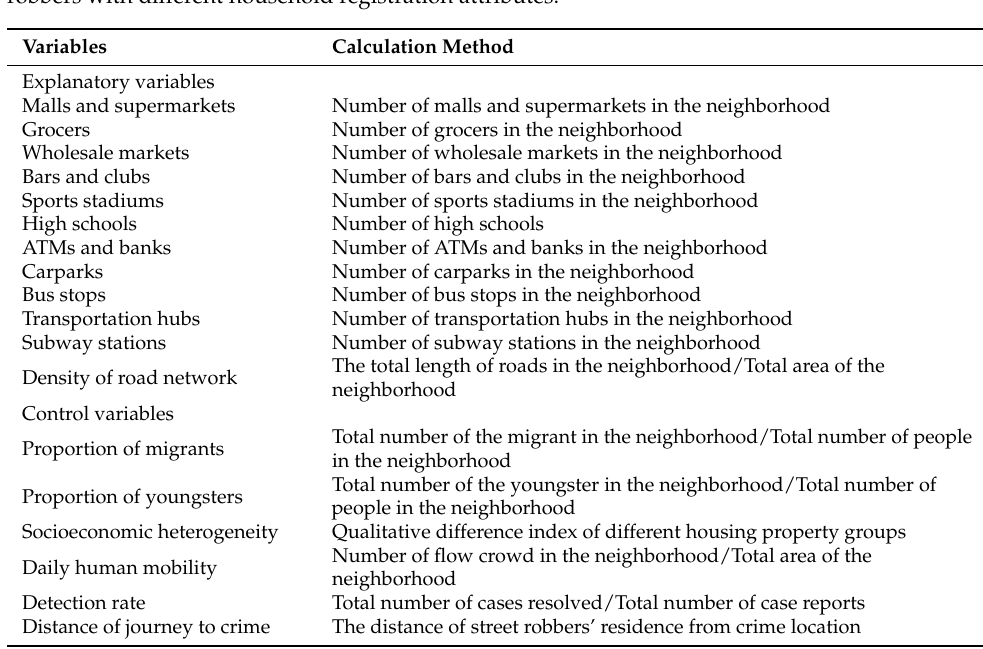
Table 3. Description of variables for comparative analyses of the crime location choices of street robbers with different household registration